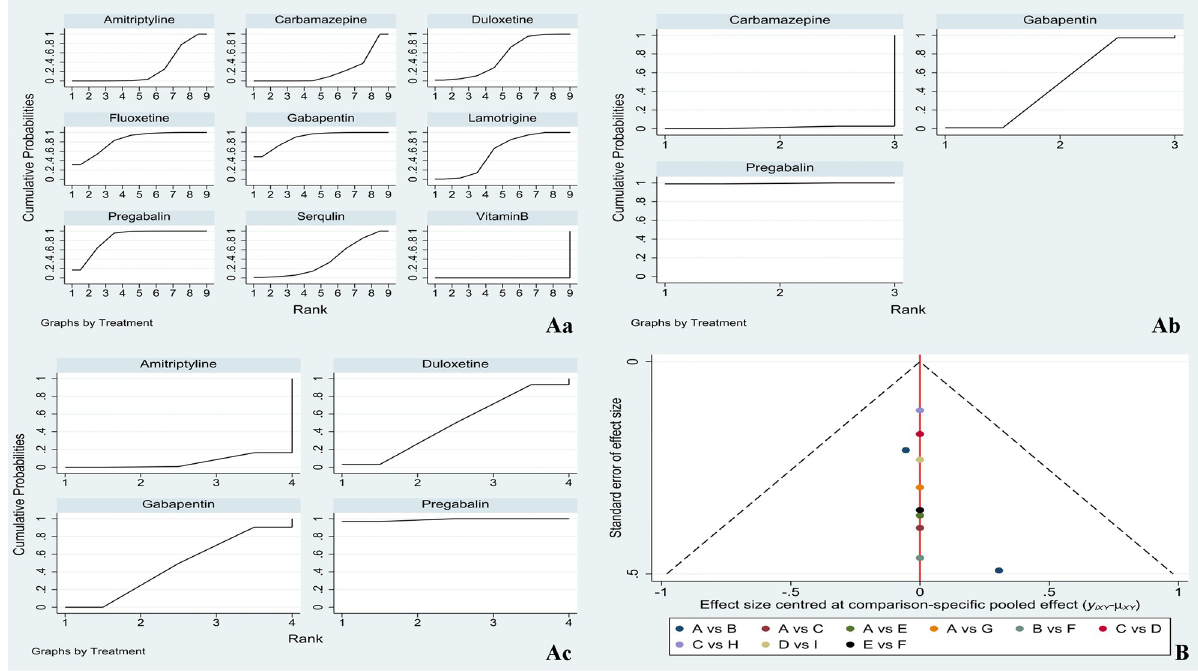
Fig 6. A : Cumulative probability ranking plot (Aa: VAS; Ab: NRS; Ac: HAMD); B : Funnel diagram of VAS.